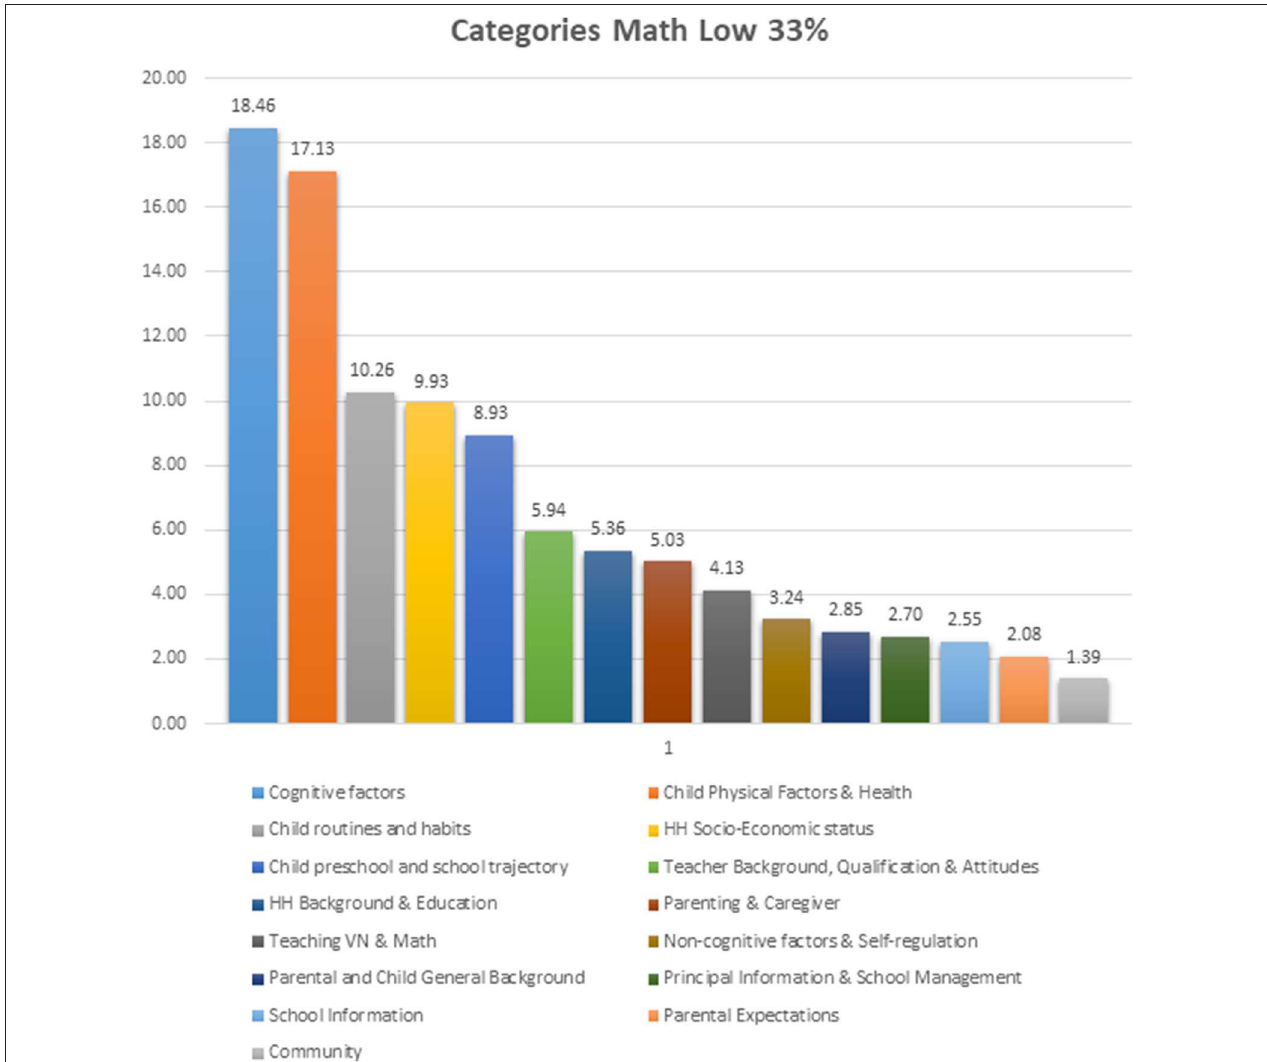
FIGURE 2 | Comparative observed predictive weight contribution for the low 33% of math performance by each of the categories of predictor